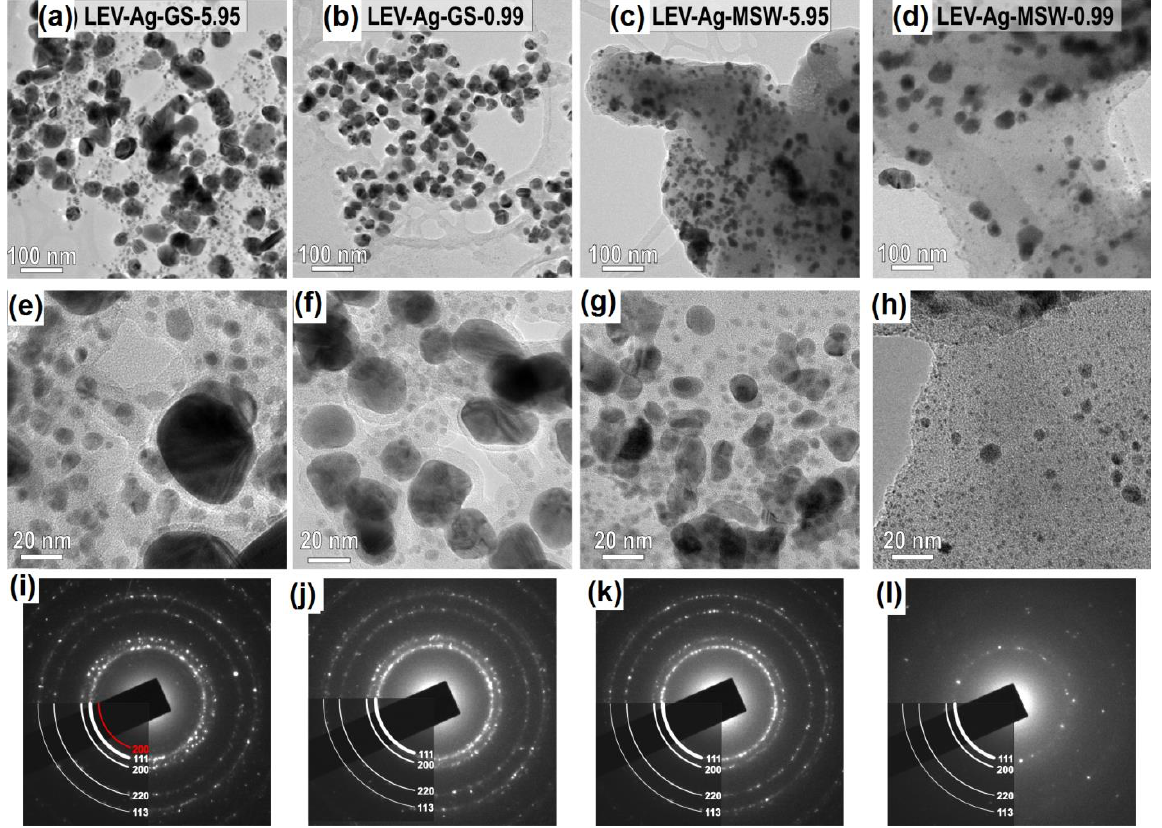
Figure 9. Transmission electron microscopy (TEM) images of Ag NPs prepared by green or mechanochemical synthesis at ( a–d ) lower and ( d–h ) higher magnification; ( i–l ) SAED patterns shown in the bottom row reveal that in all samples, the main reflections stem from elemental Ag, only in the sample ( a ) LEV-Ag-GS-5.95, a weak ring from (200) planes of the AgCl phase (marked with red color) can be observed.. The results for the corresponding samples are presented as follows: ( a , e , i ) LEV-Ag-GS-5.95; ( b , f , j ) LEV-Ag-GS-0.99; ( c , g , k ) LEV-Ag-MSW-5.95; ( d , h , l ) LEV-Ag-MSW-0.99. Sample marks are also given inthe figures ( a–d